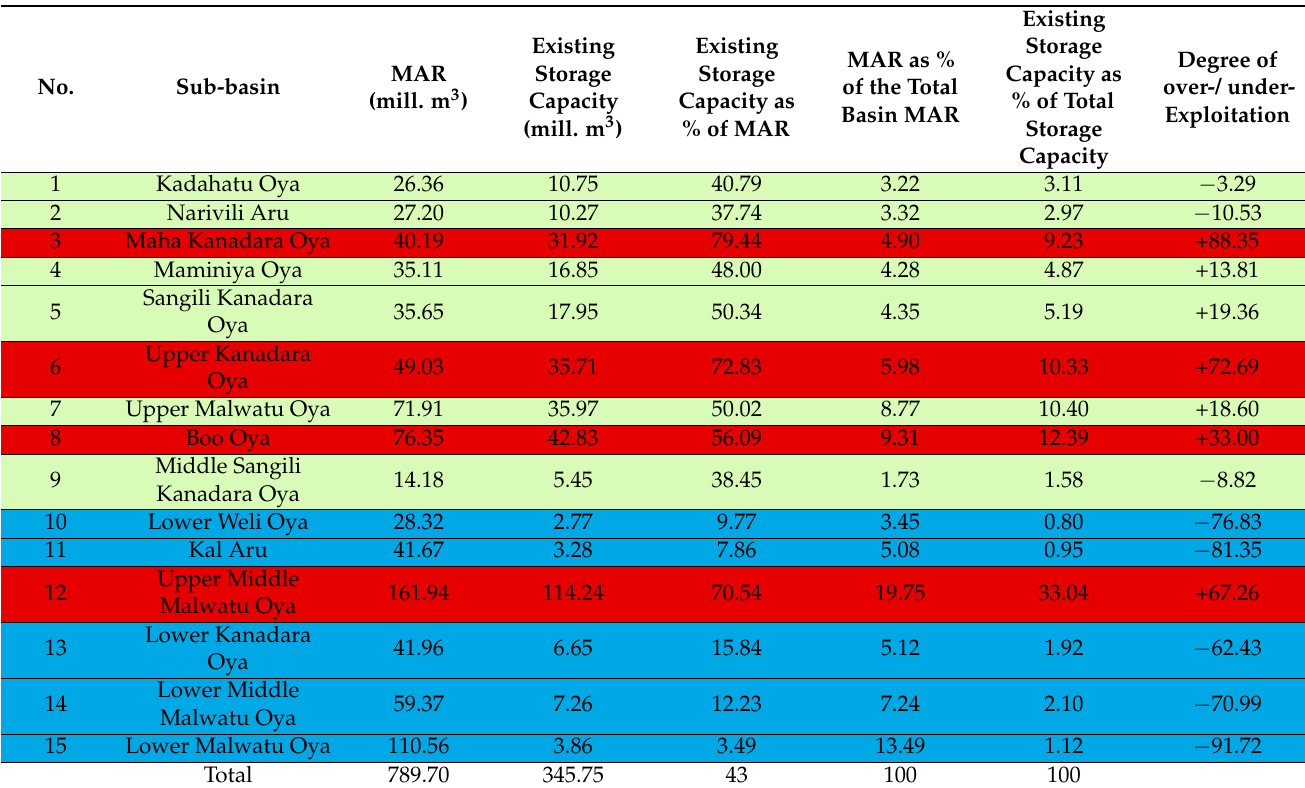
Table 4. Degree of over-/under-exploitation of large sub-basins of Malwatu Oya. Colors blue, red and green correspond to under, over and correct exploitation